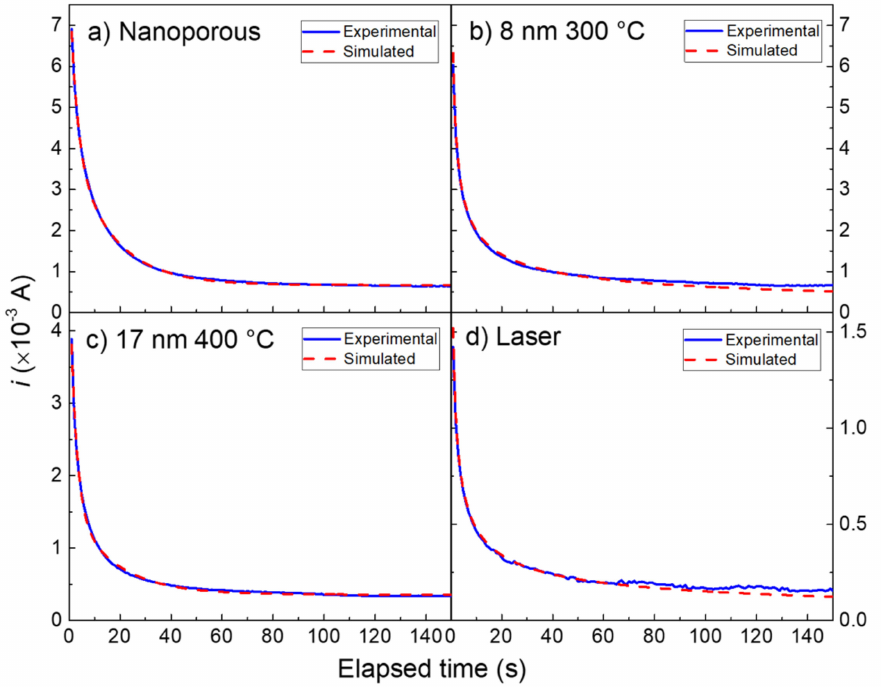
Figure 6. Current-time curves recorded for: ( a ) gold nano-porous; ( b ) 8 nm dewetted at 300 ◦ C; ( c ) 17 nm dewetted at 400 ◦ C; ( d ) laser dewetted. Conditions: glucose 10 mM in NaOH 0.1 M. (cid:113) D The terms nFAc were included in the parameter B 0 , according to Equation π